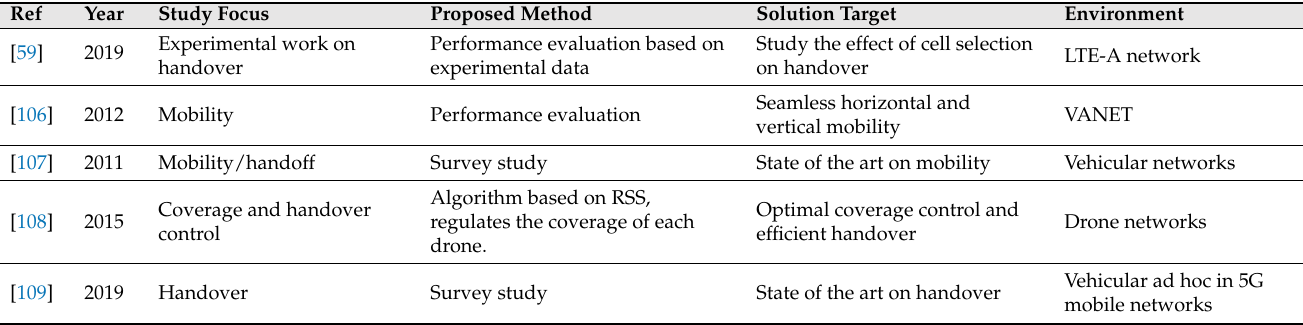
Table 3. A summary list of related works on drone mobility management and